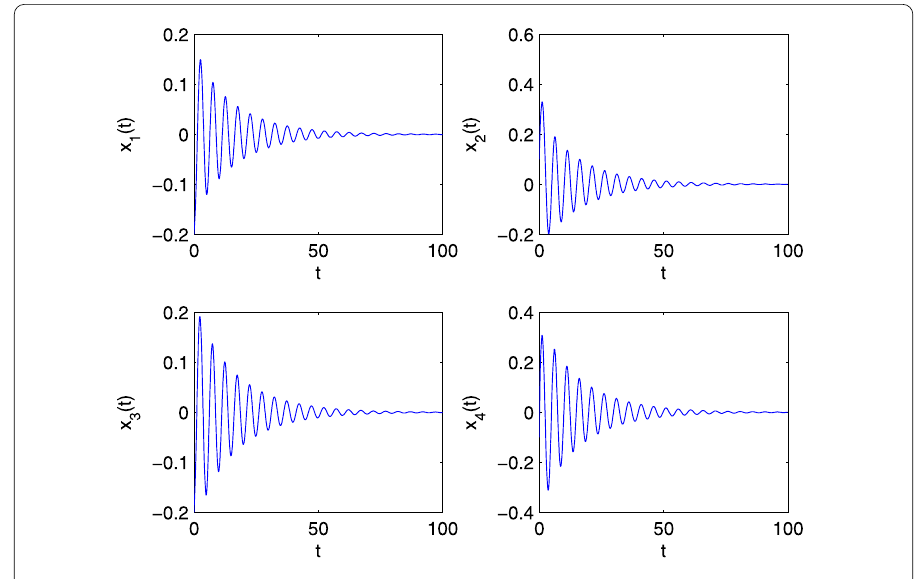
Figure 1 Time responses of system (5.1) with φ = 0.92, τ = 0.47 < τ 0 = 0.5421